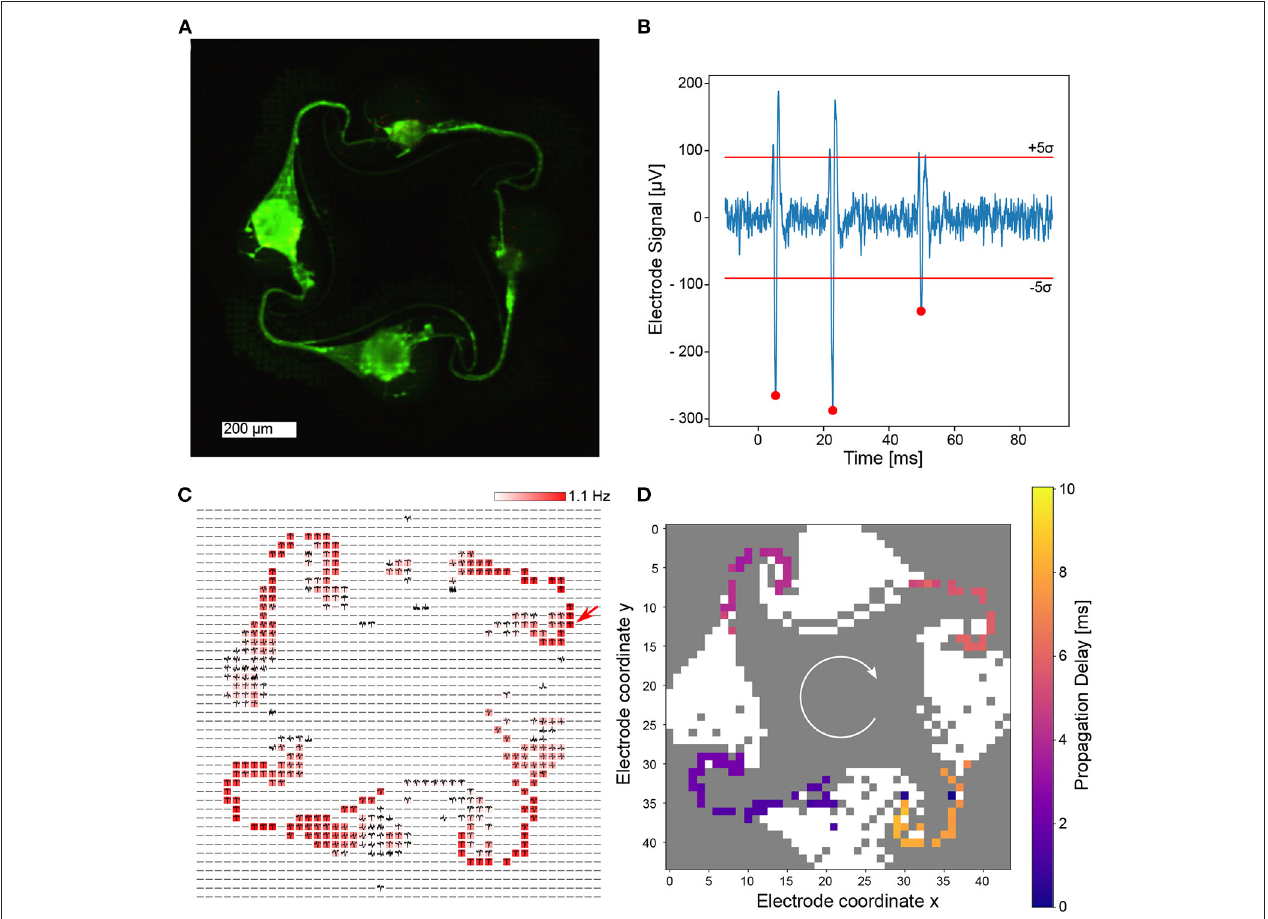
FIGURE 5 | Electrical recordings of cortical neurons growing within a PDMS microstructure at DIV 14. (A) Fluorescently stained neurons imaged at DIV 31 reveal high viability, axonal growth within the microstructure channels and a full intra-node connectivity. (B) Recording of a single electrode shows a high signal-to-noise ratio. The 5 σ threshold is indicated as well as spikes that were detected using the spike detection method described in the methods section. (C) Spike average and frequency map over 60 s on all routed electrodes within the network with color coded spiking frequency. It is evident that the spiking frequency is highest in the channels of the microstructure. The arrow indicates the electrode location at which the signal in (B) stems from. (D) A temporal analysis of spontaneous activity within a 10 ms time window indicates clockwise signal